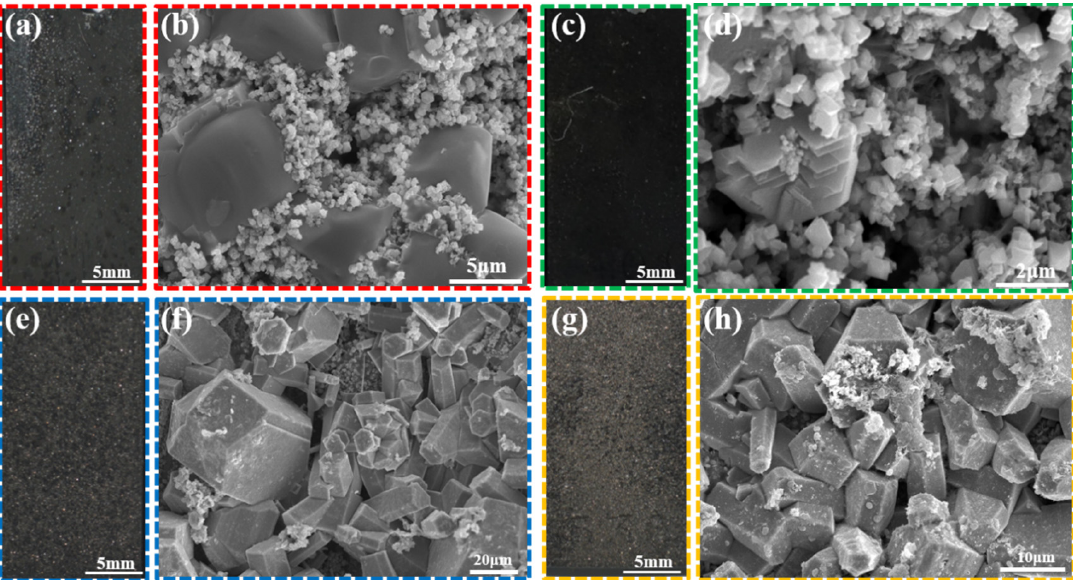
Figure 10. Macro ‐ morphology and micro ‐ morphology of T95 steel used for wellbore at various tem ‐ Figure 10. Macro-morphology and micro-morphology of T95 steel used for wellbore at various peratures in the liquid phase (( a , b ): 60 °C; ( c , d ): 90 °C; ( e , f ): 120 °C; ( g , h ): 150 °C). temperatures in the liquid phase (( a , b ): 60 ◦ C; ( c , d ): 90 ◦ C; ( e , f ): 120 ◦ C; ( g , h ): 150 ◦ C).